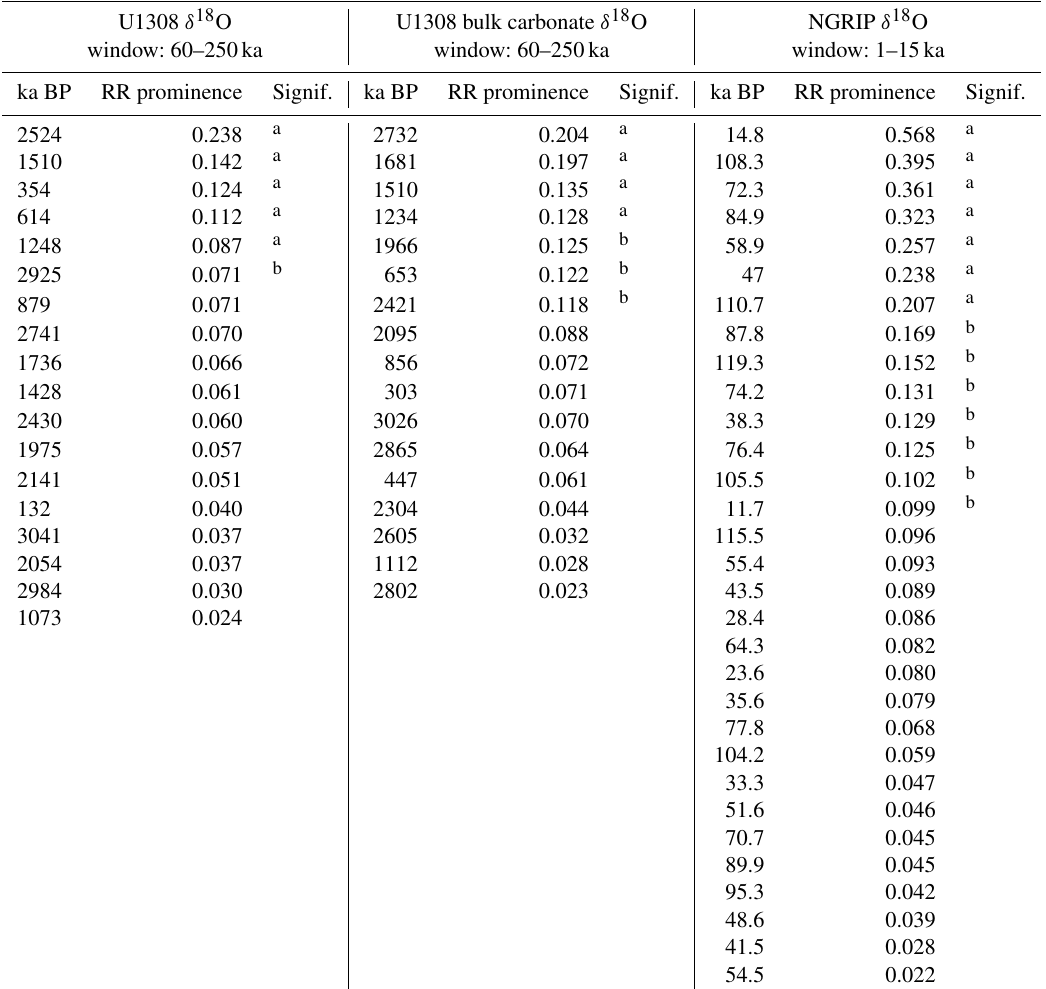
Table 1. Statistics of the recurrence rate analysis for U1308 benthic δ 18 O, U1308 bulk carbonate δ 18 O (Hodell and Channell, 2016a), and NGRIP δ 18 O (Rasmussen et al., 2014). Dates where the recurrence rate (RR) prominence is higher than the RR standard deviation are considered major transitions and are labeled with a red cross in Figs. 2c, 3c, and 4c. Periods with an RR prominence that is slightly lower than the RR standard deviation are taken into account and labeled with a pink cross in the same figures. RR prominence significance is represented in this table as follows: a shows prominence significance above the standard deviation (SD), and b shows prominence significance slightly lower than the standard